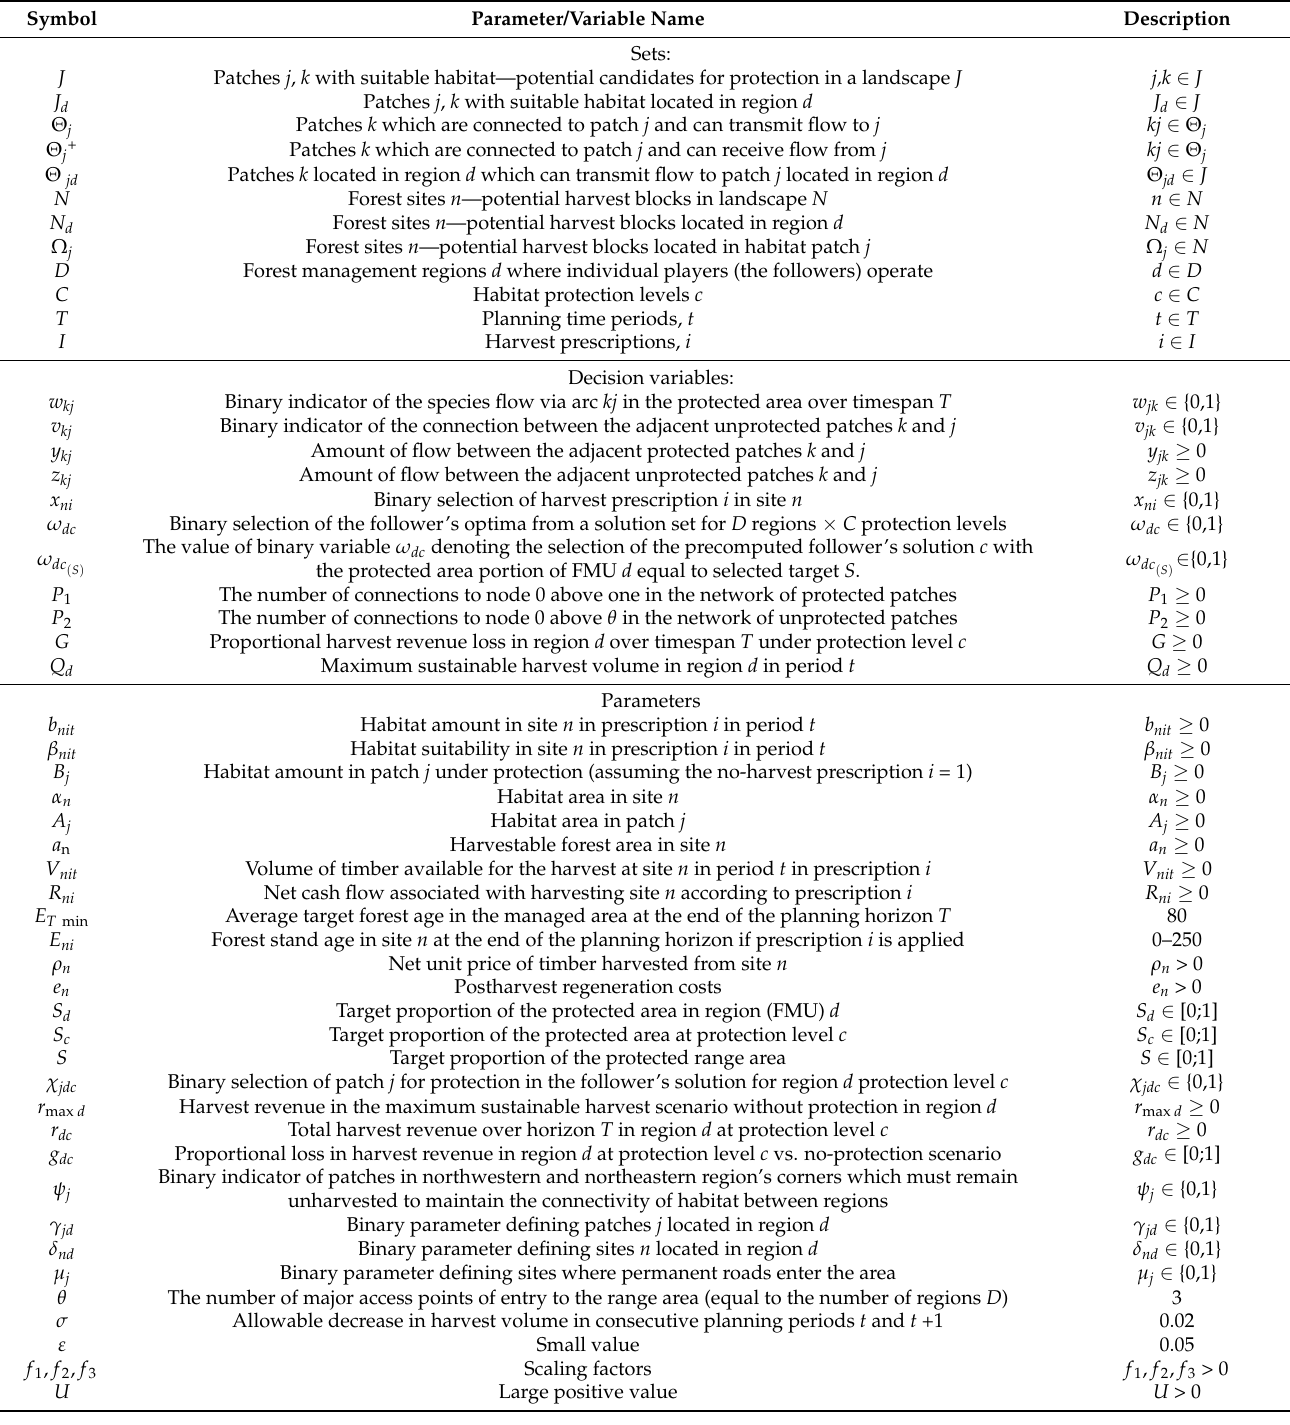
Table 1. Summary of the model variables and